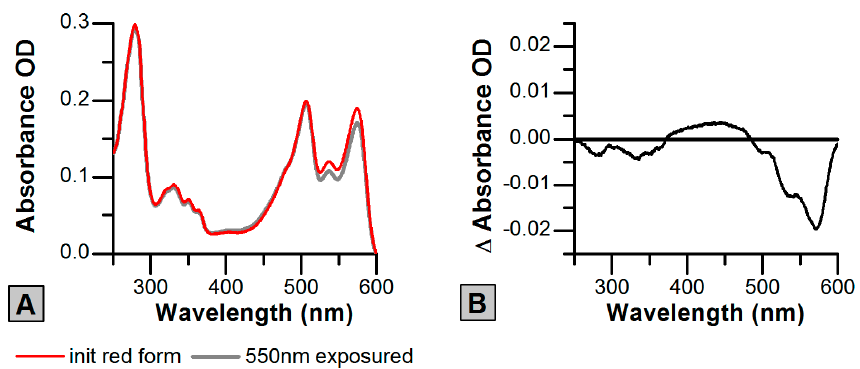
Figure 5. Absorbance spectra of R2 SAASoti ( A ) before (red line) and after 50 s 550 nm exposure (grey line). ( B ) The subtraction of initial R2 absorbance spectrum from the 550 nm (50 s) exposed protein spectrum.